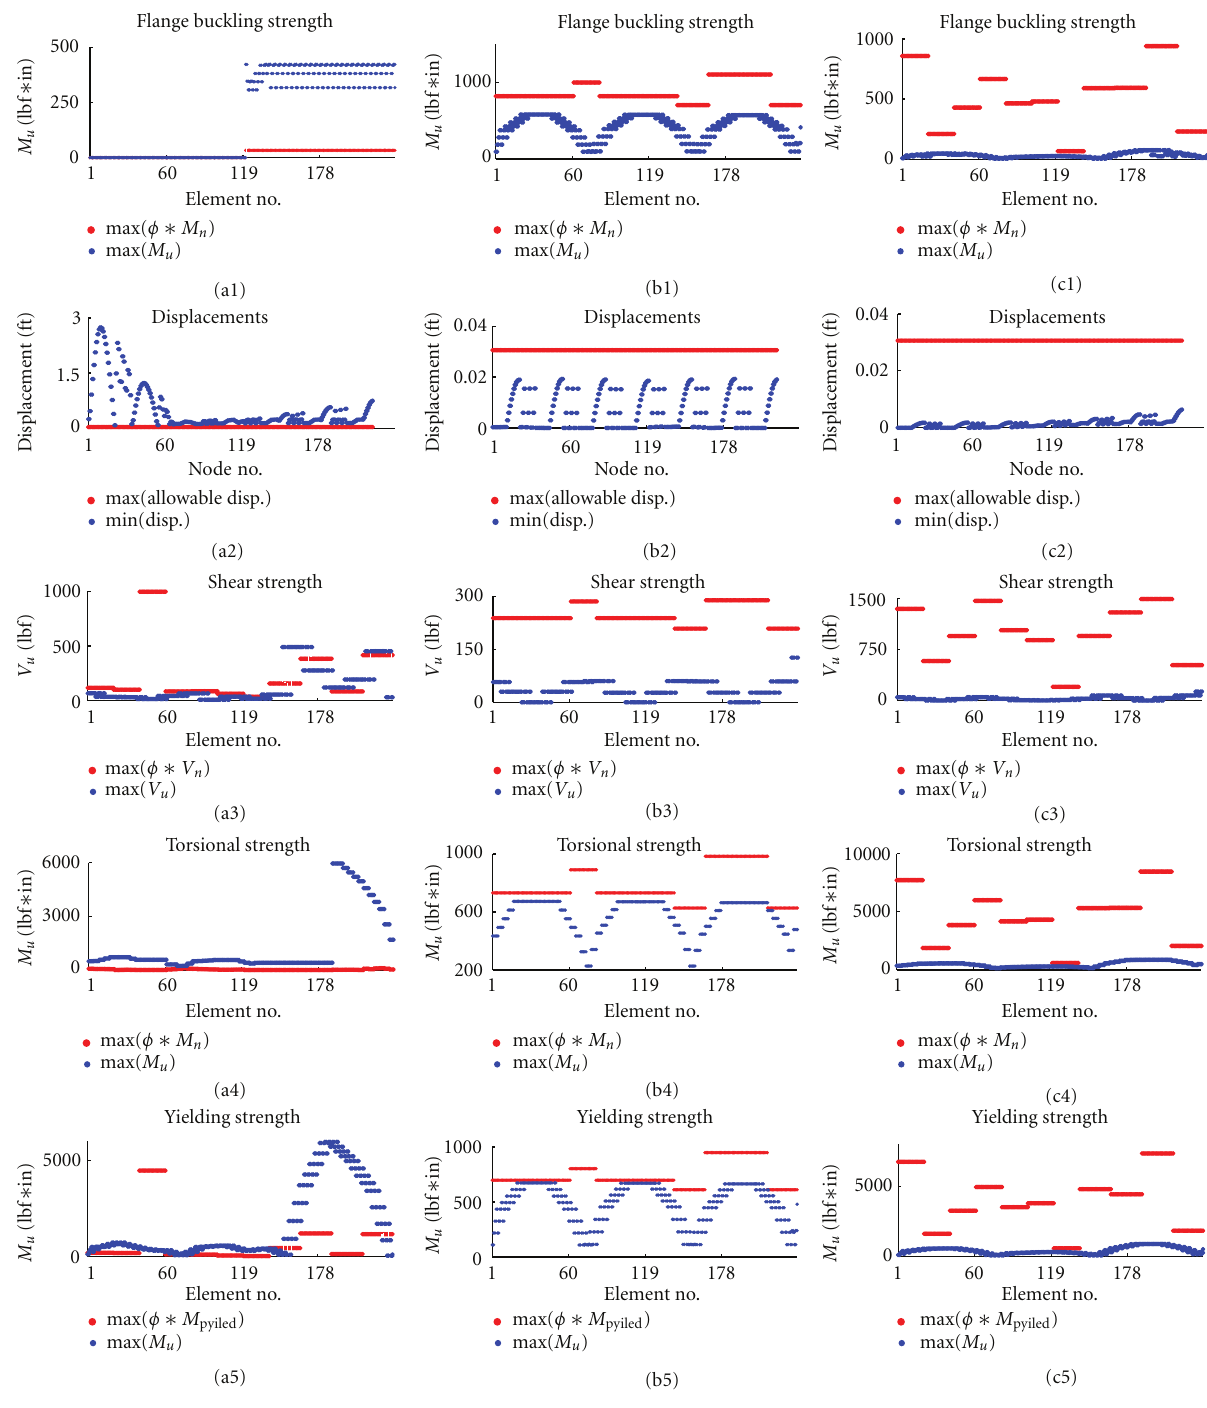
Figure 14: Strengths and displacements of random penalized solutions corresponding to minimum displacement (a1)–(a5), unpenalized solutions corresponding to maximum displacement (b1)–(b5), and maximum weight (c1)–(c5) (see Figure 13).